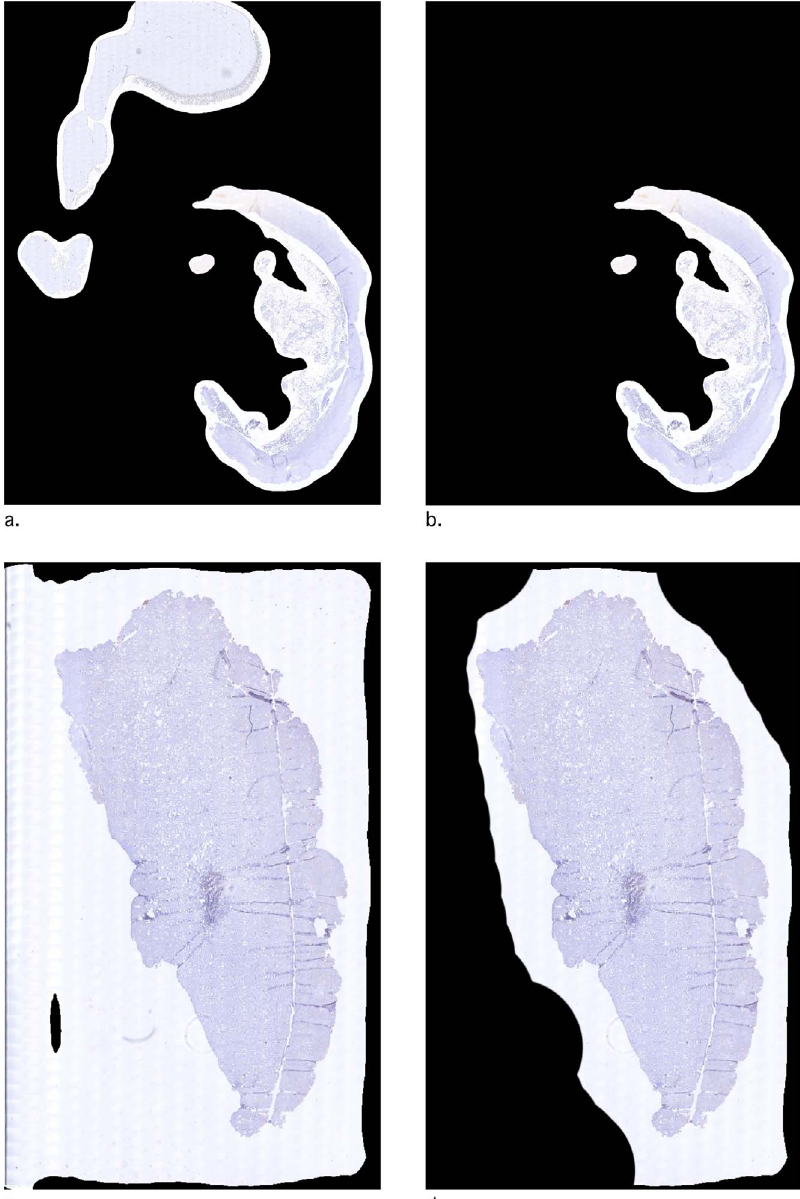
Figure 5. An example of discrepancy in mask formation. An air bubble was not masked in a., this same bubble was masked in b. The shadow of the coverslip (on the left side of the image) was not masked in c., this same shadow was masked in d. Automatically created masks should be checked manually to avoid unexpected results.